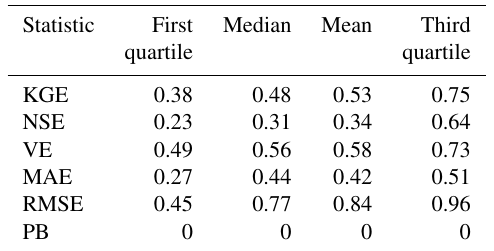
Table 1. Performance of GAM in predicting natural streamflow for the pre-regulation period across catchments quantified by dif- ferent goodness-of-fit statistics including the Nash–Sutcliffe effi- ciency (NSE; values between 0–1 with an optimum at 1), Kling– Gupta efficiency (KGE; values between 0–1 with an optimum at 1), volumetric efficiency (VE; values between 0–1 with an optimum at 1), mean absolute error (MAE; mmd − 1 ), root mean squared er- ror (RMSE; mmd − 1 ), and percentage bias (PB; %).